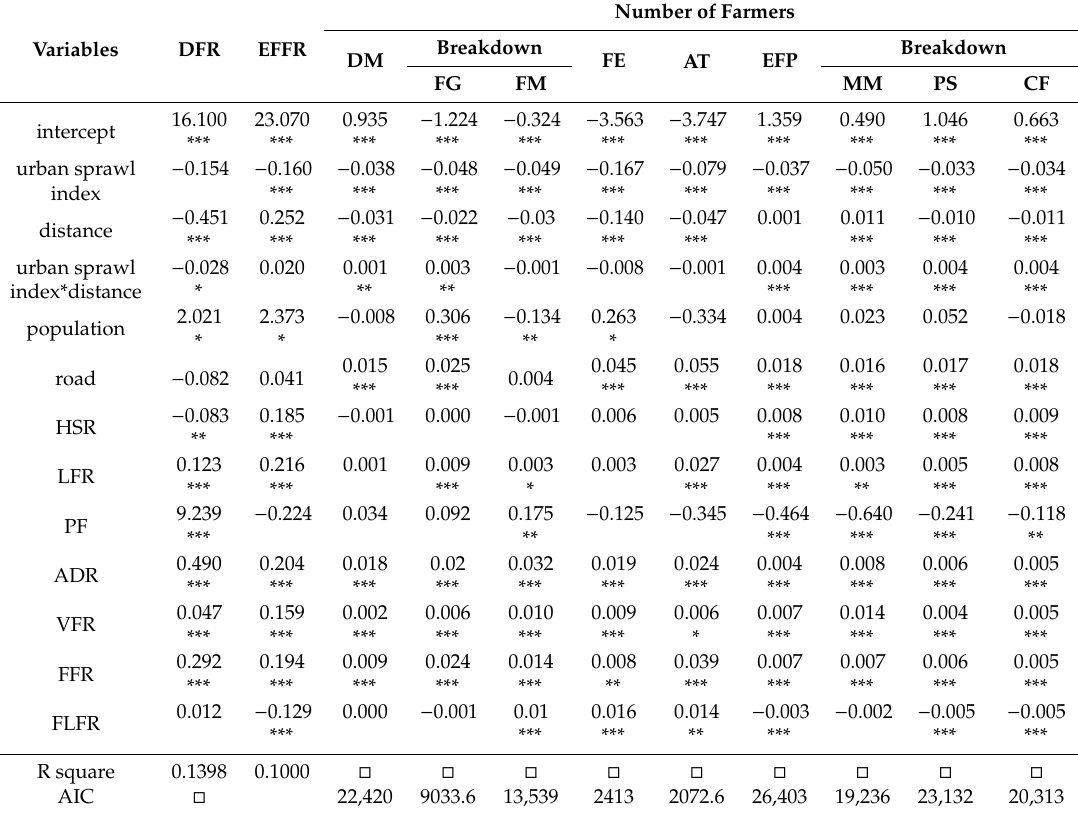
Table 7. E ff ects of urban sprawl and distance from DID on urban agricultural activities in the Osaka metro